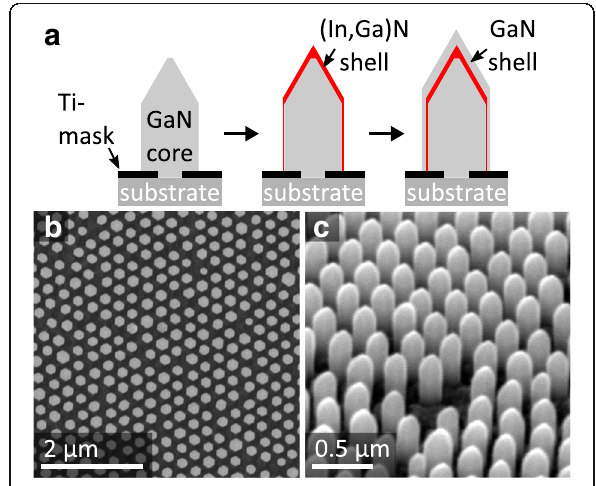
Fig. 1 a Schematic of the NW growing process. SEM micrographs of b an array of GaN/(In,Ga)N NWs from top view and c 45° tilted view with higher